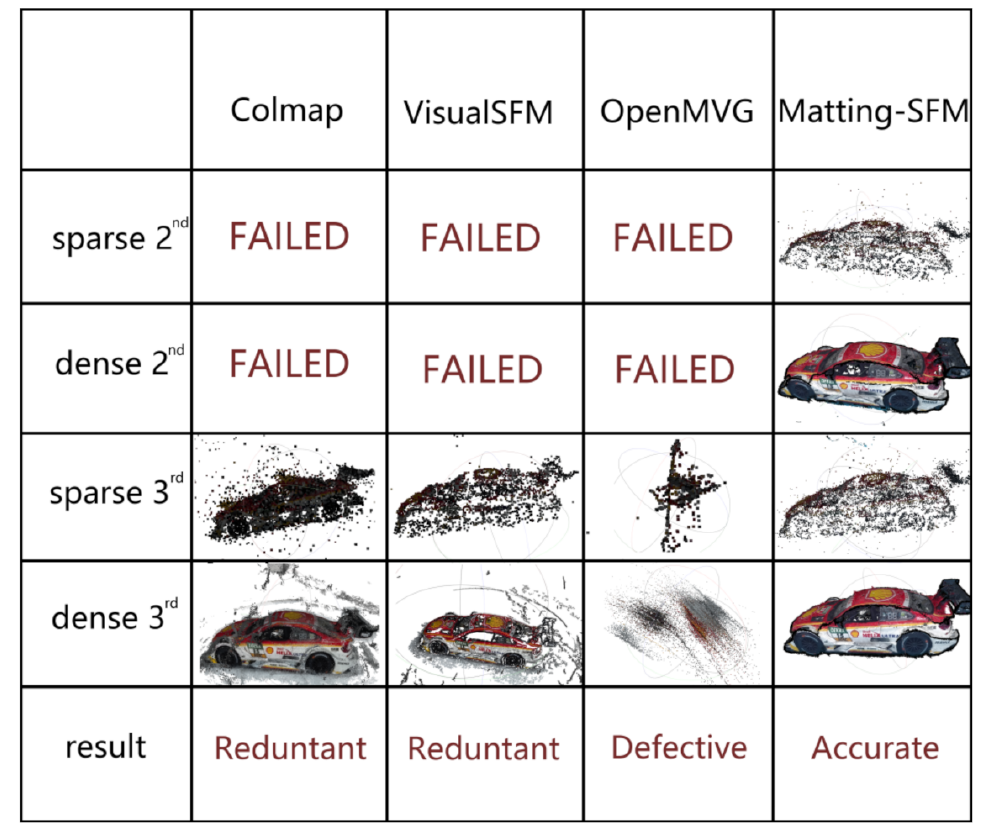
Figure 24. A comparison of all of the datasets using the visible